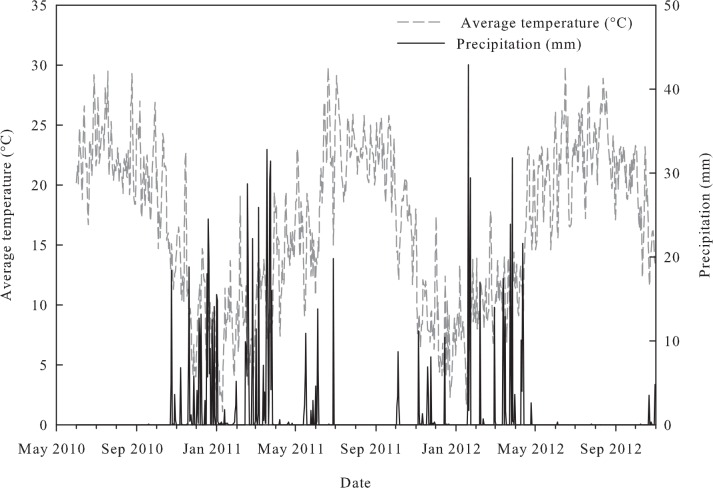
Temperature and precipitation data from May 2010 to October 2012 in Winters, CA, USA.Data is obtained from the California Irrigation Management Information System (CIMIS).